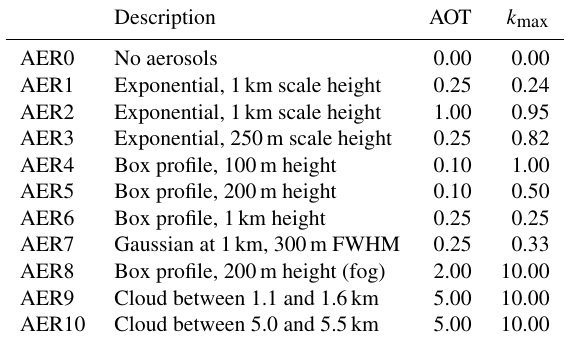
Table 3. Description of the aerosol extinction profiles shown in Fig. 2. The maximum extinction k max is given per kilometre.